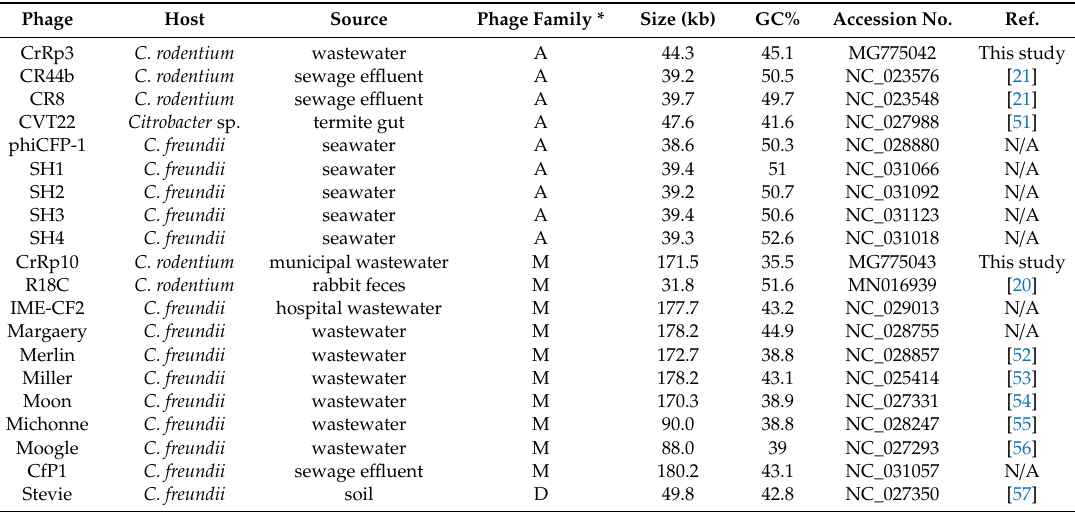
Figure 1. Morphology, genome organization and gene functional comparison of CrRp3. ( a ) Electron micrographs of CrRp3 negatively stained with uranyl acetate. ( b ) Plaque forming units (highlighted by arrows) produced by CrRp3 on lawns of C. rodentium ICC180 after 24 h of growth. ( c ) Genome alignment of CrRp3 and its closest taxonomic relative E. coli phage K1-5. Genes are colored according to nucleotide sequence homology, with genes exclusive to CrRp3 labeled red, genes exclusive to K1-5 labeled yellow, and homologous genes with < 70% identity labeled blue. Table 1. Citrobacter phages and their genome